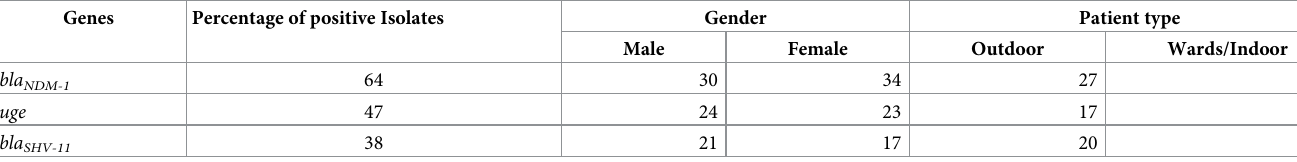
Table 2. Prevalence of bla NDM-1 , bla SHV-11 , uge in top multi-drug resistant KPN samples (n = 100). Genes Percentage of positive